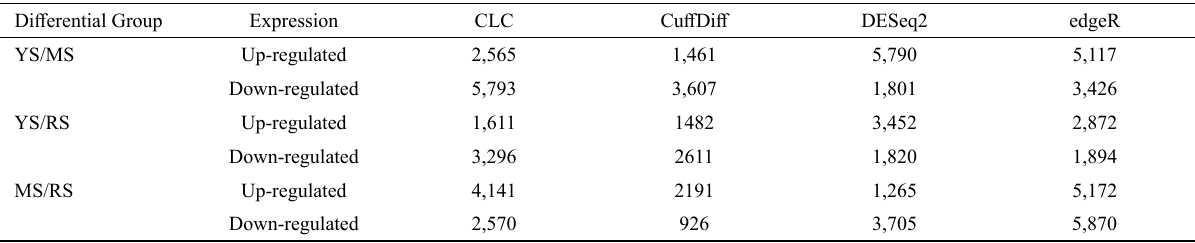
Table 2 − Total number of identified DEGs using four tools of CLC, CuffDiff, DESEq2, and edgeR.